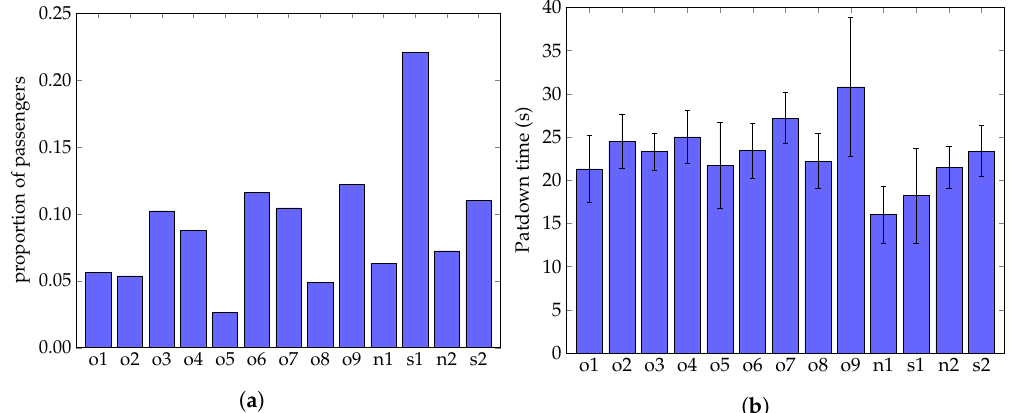
Figure 12. Statistics related to patdowns for the 13 different security checkpoint lanes. ( a ) The proportion of passengers that receive a patdown. ( b ) The mean patdown time in a lane, along with the standard